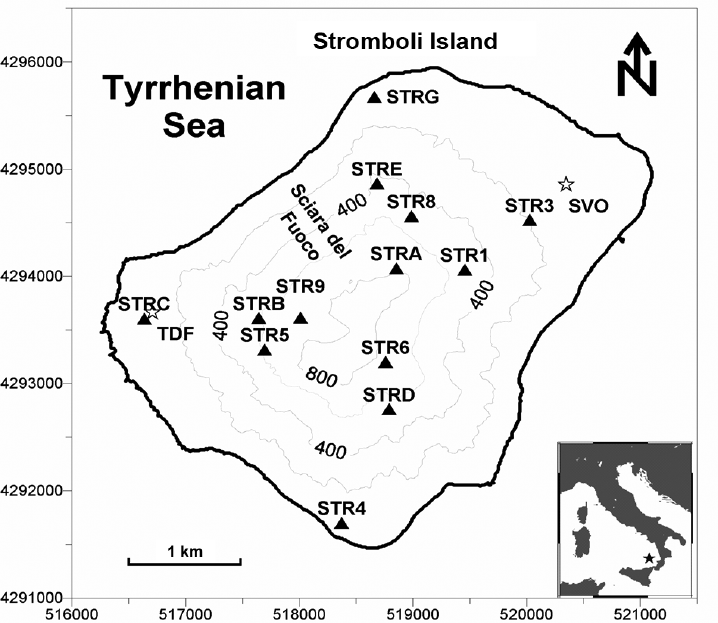
Fig. 1. Map of Stromboli volcano: the triangles indicate the 13 seismic stations of the permanent broadband network; the stars specify the locations of the two strainmeters (SVO and TDF). The inset shows a map of Italy with the position of Stromboli marked (star). The scale is expressed in UTC